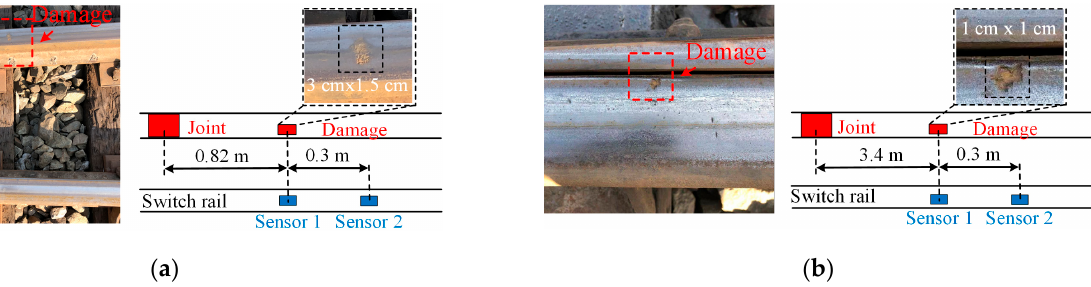
Figure 9. The other damage and location parameters: ( a ) damage 1 and location; ( b ) damage 2 and location.